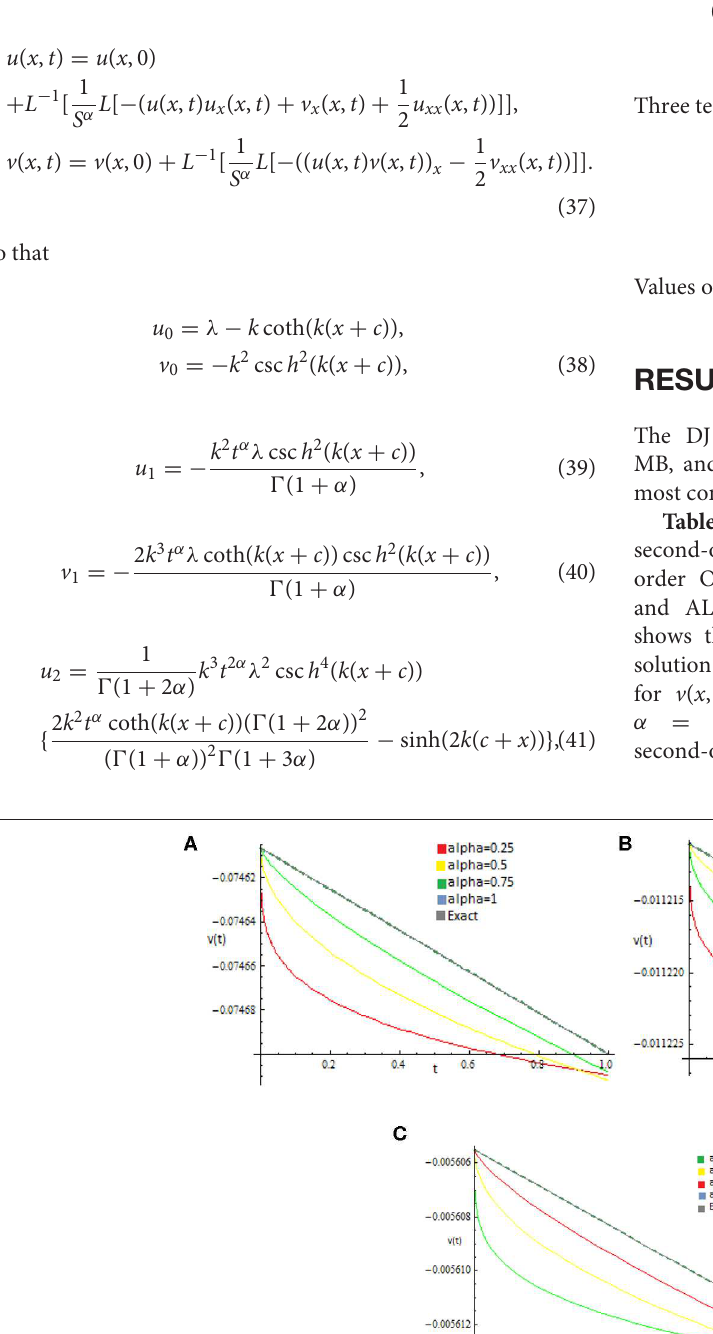
FIGURE 3 | 2D curves for v ( x , t ) part of (A) WBK equation, (B) MB equation, (C) ALW equation at x